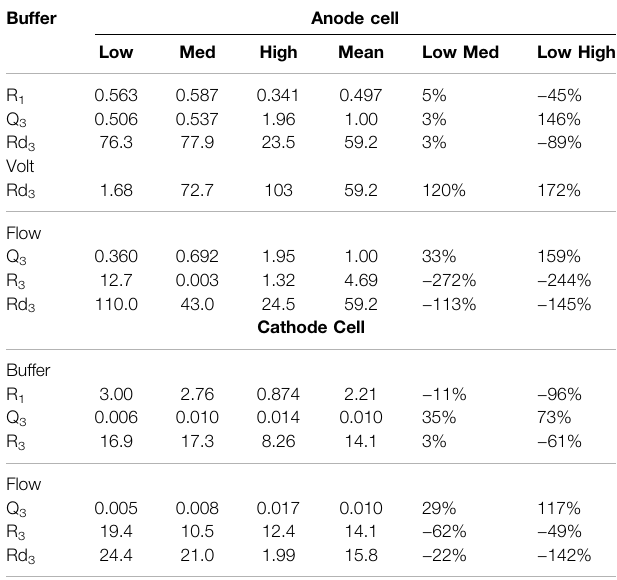
TABLE 2 | Mean values and percent deviation from overall average of relevant EIS parameters for the lowest, medium, and highest settings tested.